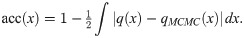
Box plots of the accuracy measurements for the predictive distribution of the proportions of occupied sites associated with the Laplace method for number of sites n = 50, 100 and number of visits to each site K = 2; 3; 4 and 5.The accuracy of the VB approximations is measured by calculating acc(x)=1−12∫|q(x)−qMCMC(x)|dx. The measure lies between 0 and 1 with a value of 1 indicating a perfect approximation and a value close to 0 indicating a poor approximation by the variational distribution to the true posterior distribution.